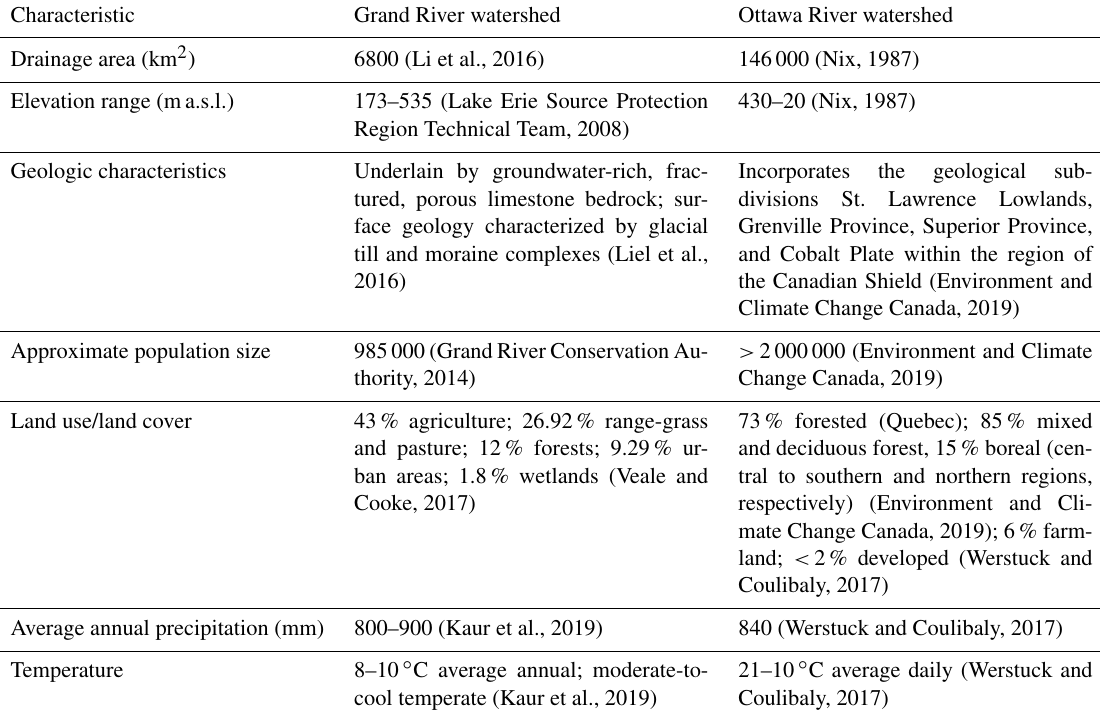
Table 2. Study watershed